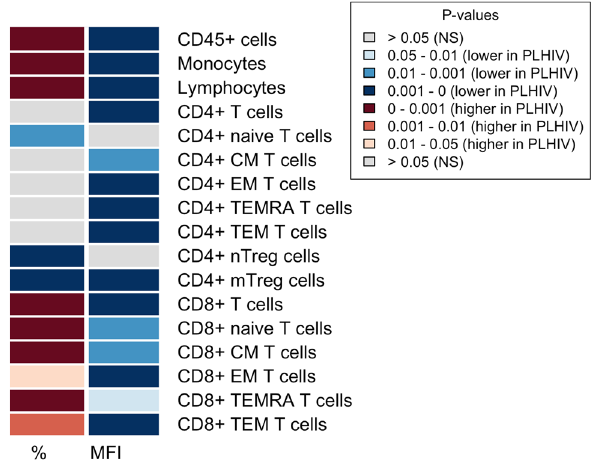
Figure 2. CCR5 expression in circulating immune cells in PLHIV versus controls. Multiple linear regression analysis was used to evaluate the effect of cohort (PLHIV vs. controls) on CCR5 expression levels (percentage (%) of CCR5+ cells or CCR5 mean fluorescence intensity (MFI)) on cell types listed in the rows, when adjusting for age, sex, CMV-serostatus, and smoking. The columns show the differences in the percentage of CCR5+ cells (left column) and CCR5 MFI (right column) between PLHIV and controls. Significance (FDR corrected) of the difference in CCR5 expression between PLHIV and controls is presented by the colours. Blue colour refers to lower CCR5 expression in PLHIV, while red refers to higher expression in PLHIV compared to controls.